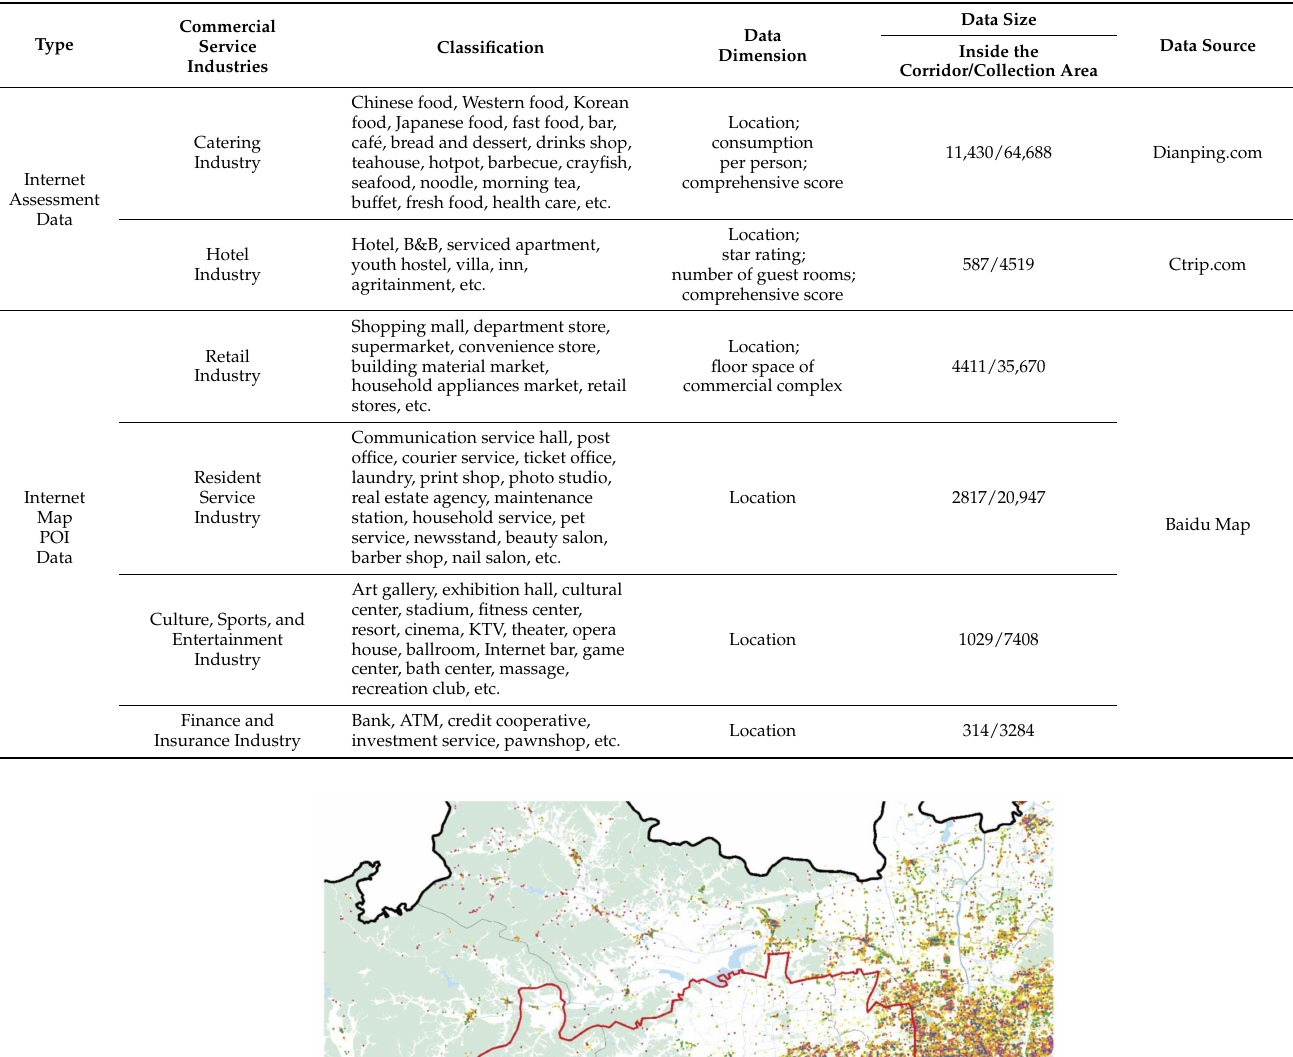
Table 1. Information of commercial facilities data.